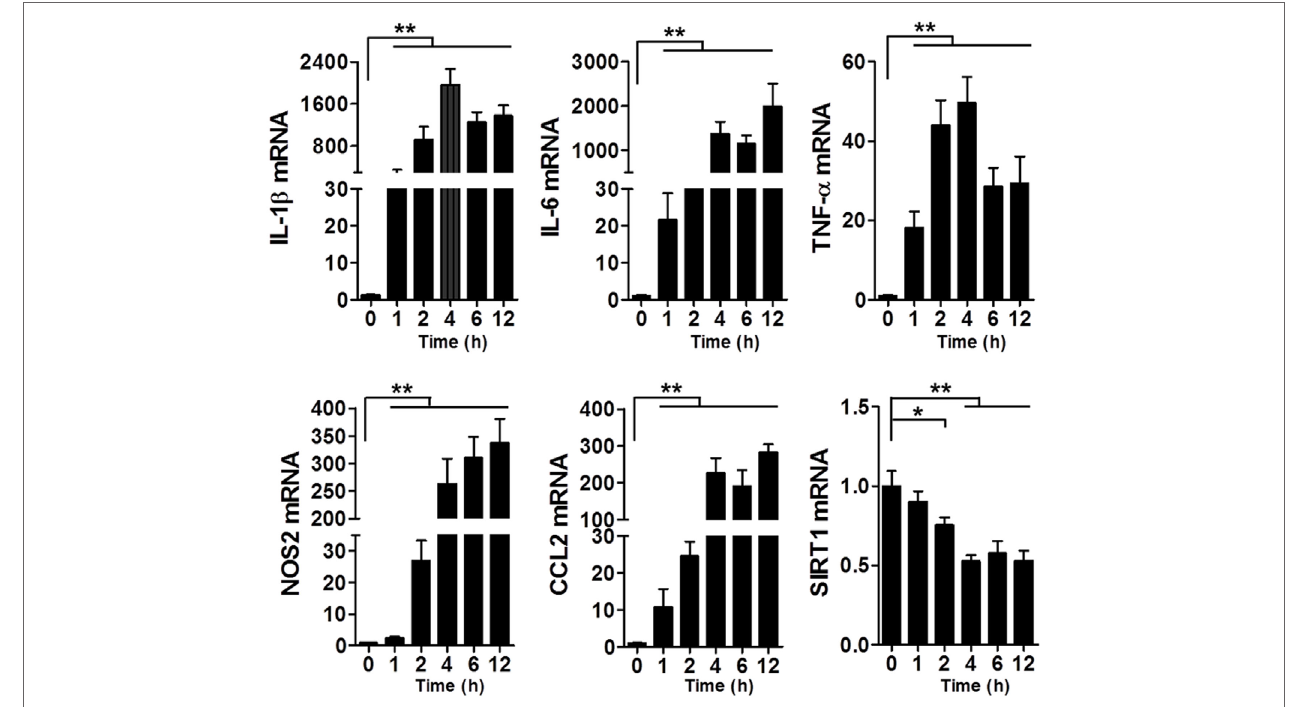
FigUre 1 | Levels of IL-1 β , IL-6, TNF- α , NOS2, CCL2, and SIRT1 mRNAs in lipopolysaccharide-treated and untreated RAW264.7 cells. *p < 0.05, **p < 0.01; n =